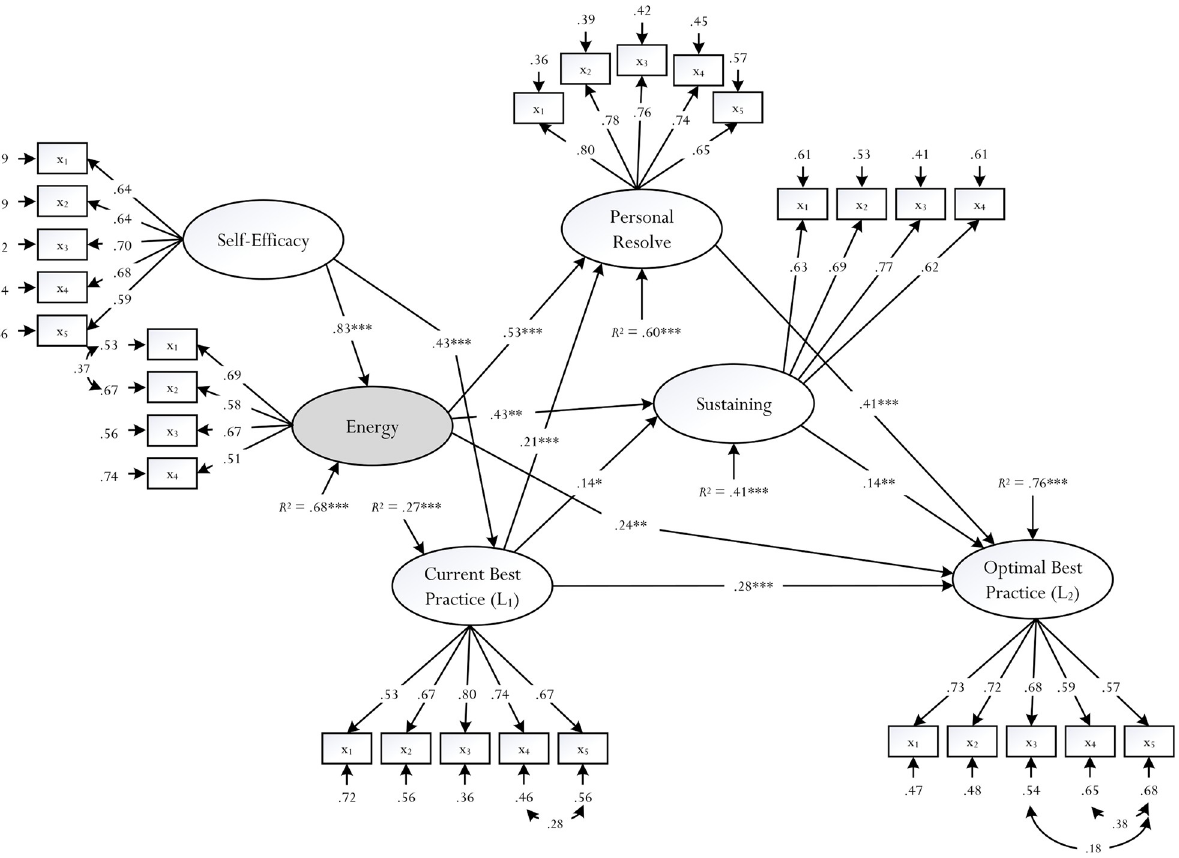
Fig 3. Final solution. Statistically significant paths at � p < .05, �� p < .01, ��� p < .001 are shown, whereas non-statistically significant paths have been omitted for clarity. Measured indicators for each proposed latent factor (e.g., self-efficacy) are depicted as X 1 , X 2 , ... , X n , where n = 1, 2, ... , 5.